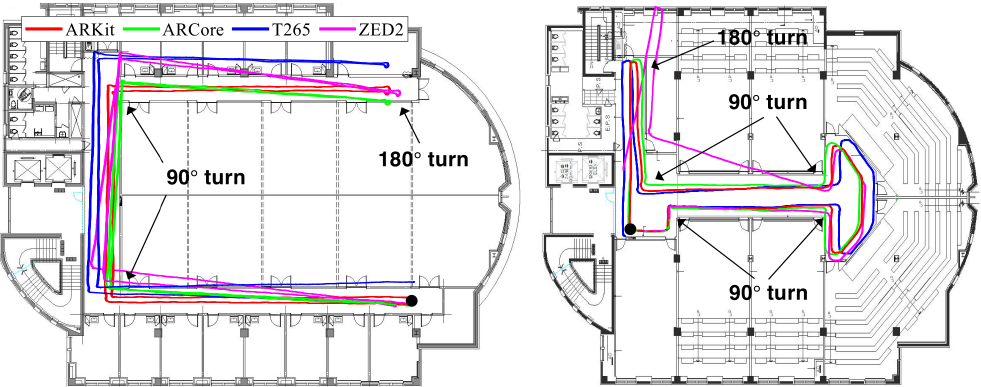
Figure 6. Trajectories estimated by the four proprietary VIO systems in the long U-shaped corridor ( left ) and open hallway space ( right ) sequences. We started and ended at the same point, which is marked with a black circle, to evaluate the loop-closing performance of the tested commercial VIO systems. The 90 ◦ and 180 ◦ turns gauged the ability of the VIO algorithms to handle rotations in the yaw direction. The estimated paths for ARKit (red) matched the building floor plan most consistently, and only the starting and ending points of ARKit nearly met; for the others, they did